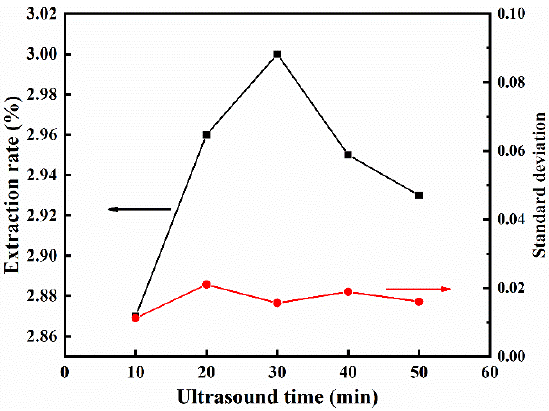
Figure 7. Effect of sonication time on extraction rate. (The black arrow represents the extraction rate curve and the red arrow represents the standard deviation curve.)